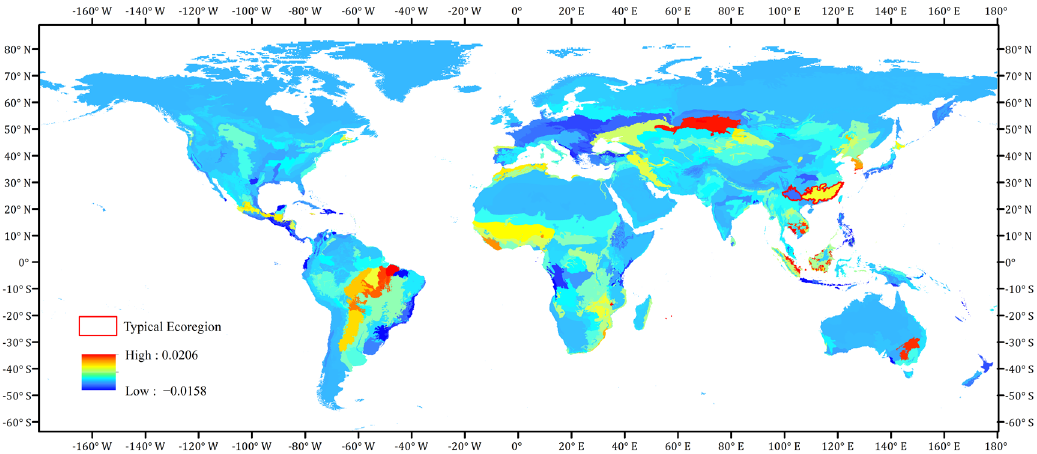
Figure 4. The means of LSS change rates at an ecoregional scale, from 1992 and 2018. Two typical ecoregions are bordered with red.